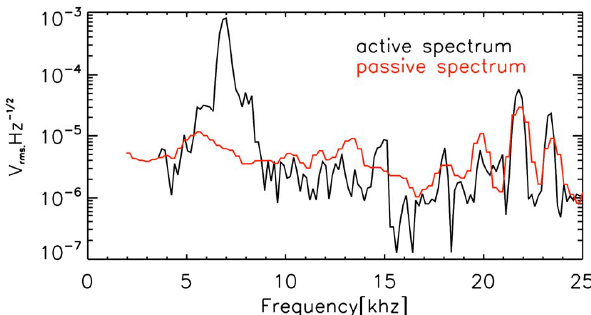
Fig. 4. Detailed view of the F lh resonance triggered by the Figure 4. Detailed view of the F lh resonance triggered by the WHISPER sounder on C2 satellite, at WHISPER sounder on C2 satellite, at 18:04UT, on 12 July 2010. 18:04 UT, on July 12th, 2010. The active spectrum (black line) is compared to the passive spectrum The active spectrum (black line) is compared to the passive spec- measured 2 seconds later (red line). trum measured 2s later (red